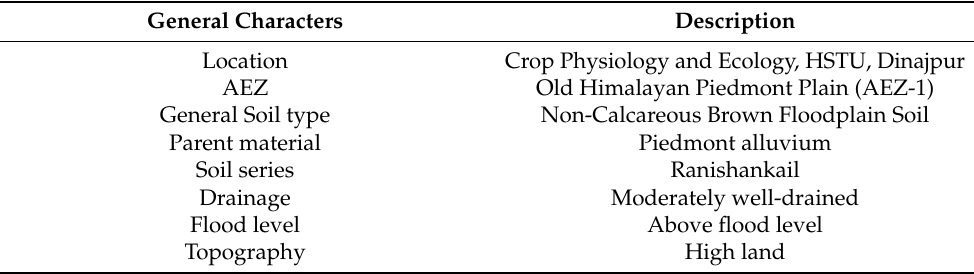
Table 1. General characteristics of soil of the experimental site.